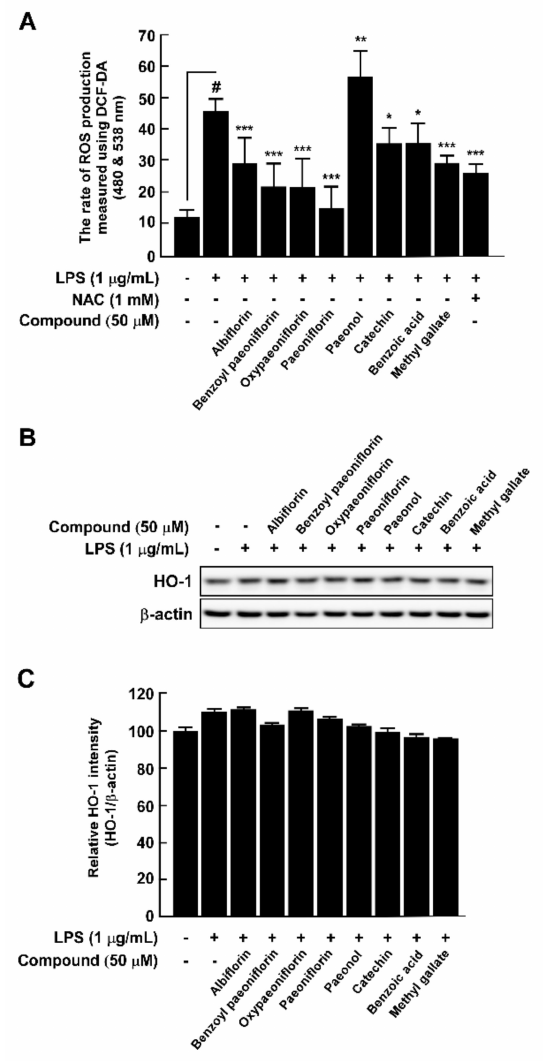
Figure 5. Antioxidant activity of Paeonia lactiflora extract (PLE) compounds against LPS-induced RAW264.7 cells. ( A ) Reactive oxygen species (ROS) production was determined using the 2 (cid:48) ,7 (cid:48) - dichlorofluorescein diacetate (DCF-DA) method at 480 and 538 nm. An effective ROS inhibitor, N -acetyl cysteine (NAC, 1 mM), was used as a positive control. ( B ) HO-1 expression in RAW264.7 cells was measured using Western blotting. ( C ) HO-1 protein content was normalized to β -actin and quantified by ImageJ software. # p < 0.05, compared with the control group; * p < 0.05, ** p < 0.01, and *** p < 0.001, compared with the group exposed to LPS alone. Data are presented as the mean ± standard deviation of three independent